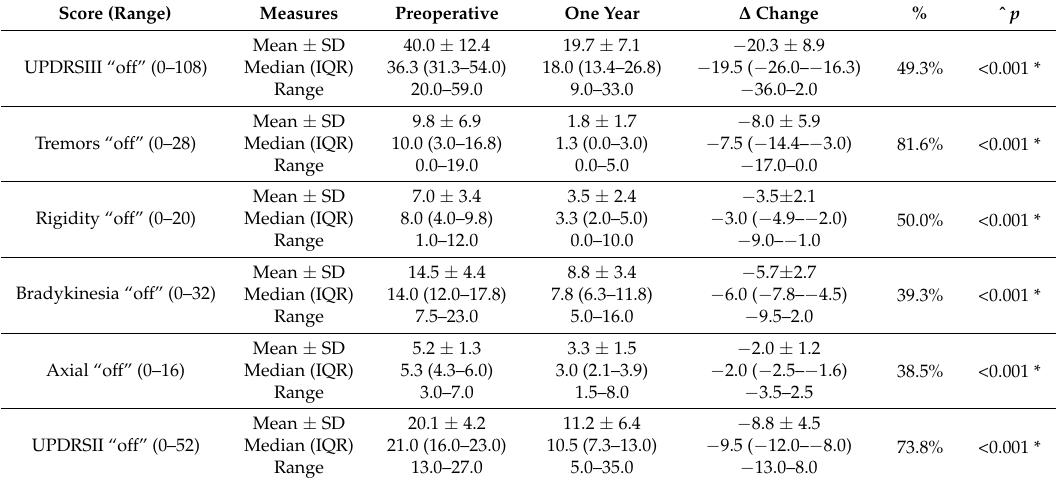
Table 2. Changes in the “off” medications UPDRS III and UPDRS II